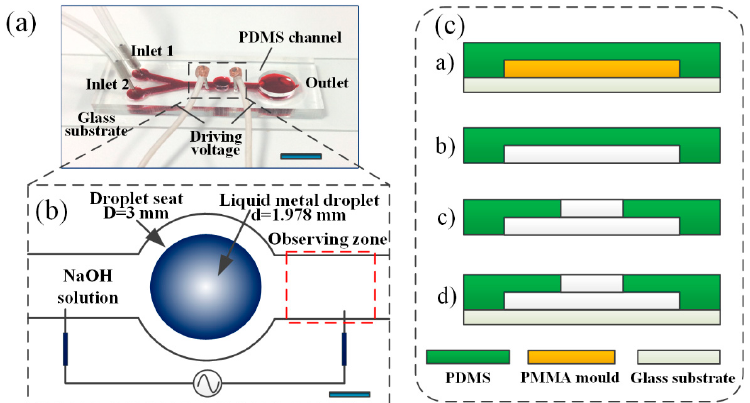
Figure 1. Design and fabrication process of the microfluidic mixer. ( a ) The schematic view of the liquid metal based microfluidic mixer. Scale bar, 6 mm; ( b ) the detailed mixer actuator. Scale bar, 500 μ m; ( c ) fabrication processes of the microfluidic mixer including: (a) polydimethylsiloxane (PDMS) was poured and cured onto a glass slide; (b) the PDMS mixture was peeled off; (c) holes were punched; (d) PDMS channel was plasma bonding onto a glass